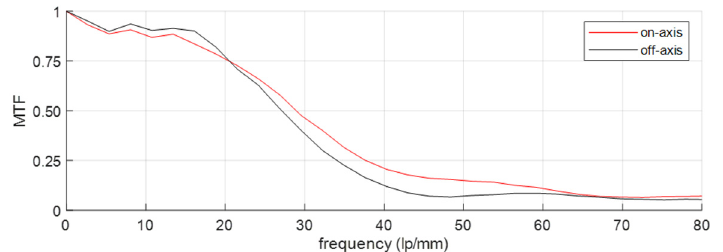
Figure 12. Measured MTF for the thermal camera channel, for the on-axis and off-axis (at 164°) configurations, surpassing the current state of the art.